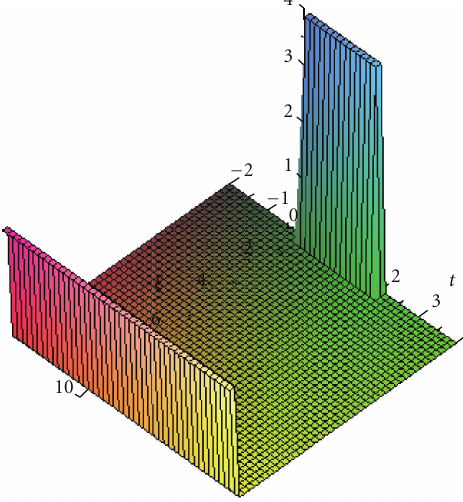
Figure 2: Illustrative sketch for the combination of the space- time dependent external neutron sources for the two-energy group solution.